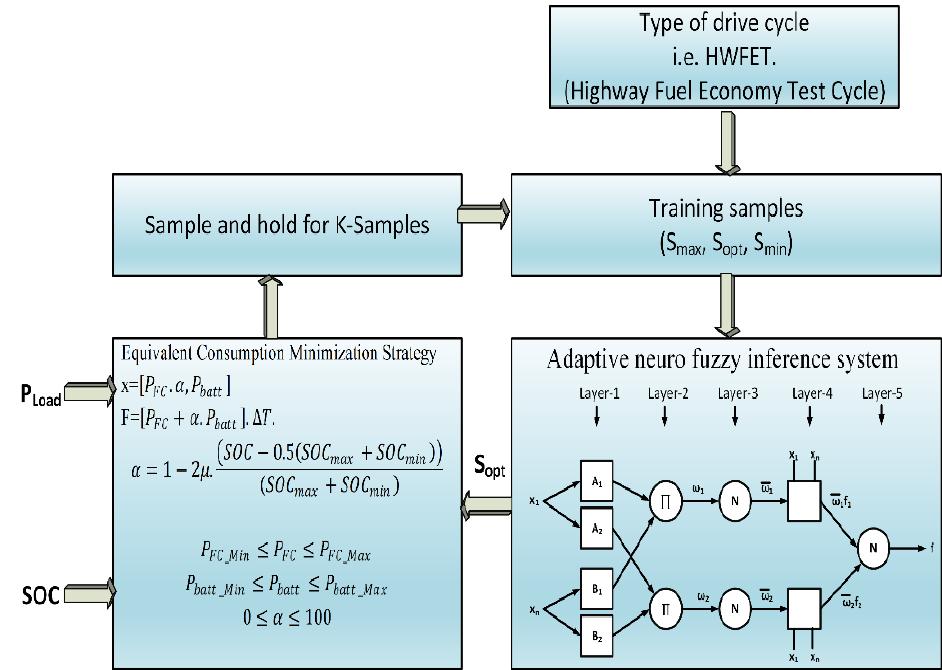
Figure 11. Flowchart of hybrid power management scheme (HPMS).